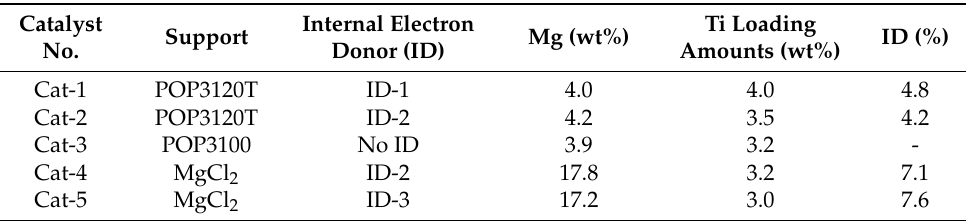
Table 2. Supported Ziegler–Natta catalysts for propylene polymerization. Catalyst